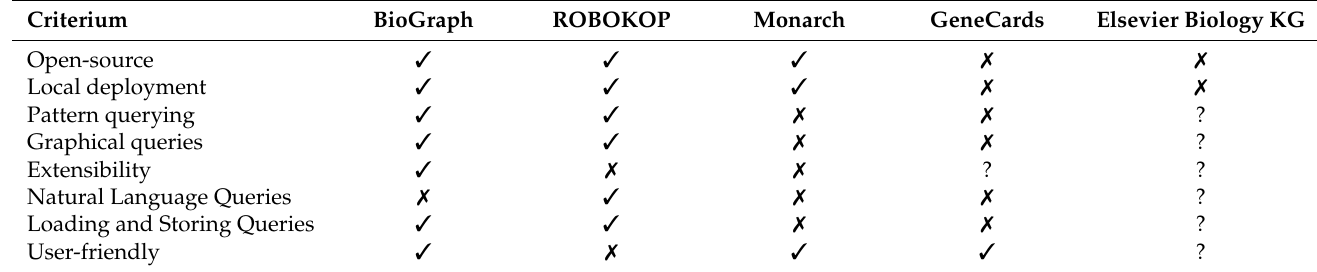
Table 1. Most details about the Elsevier Biology Knowledge Graph [16] are missing due to its closed-source nature. Table 1. Comparison between the BioGraph system and currently existing solutions. The BioGraph system fulfills all the given criteria, except natural language queries, when compared to similar systems. The question marks in the table represent the states where the criteria could not be